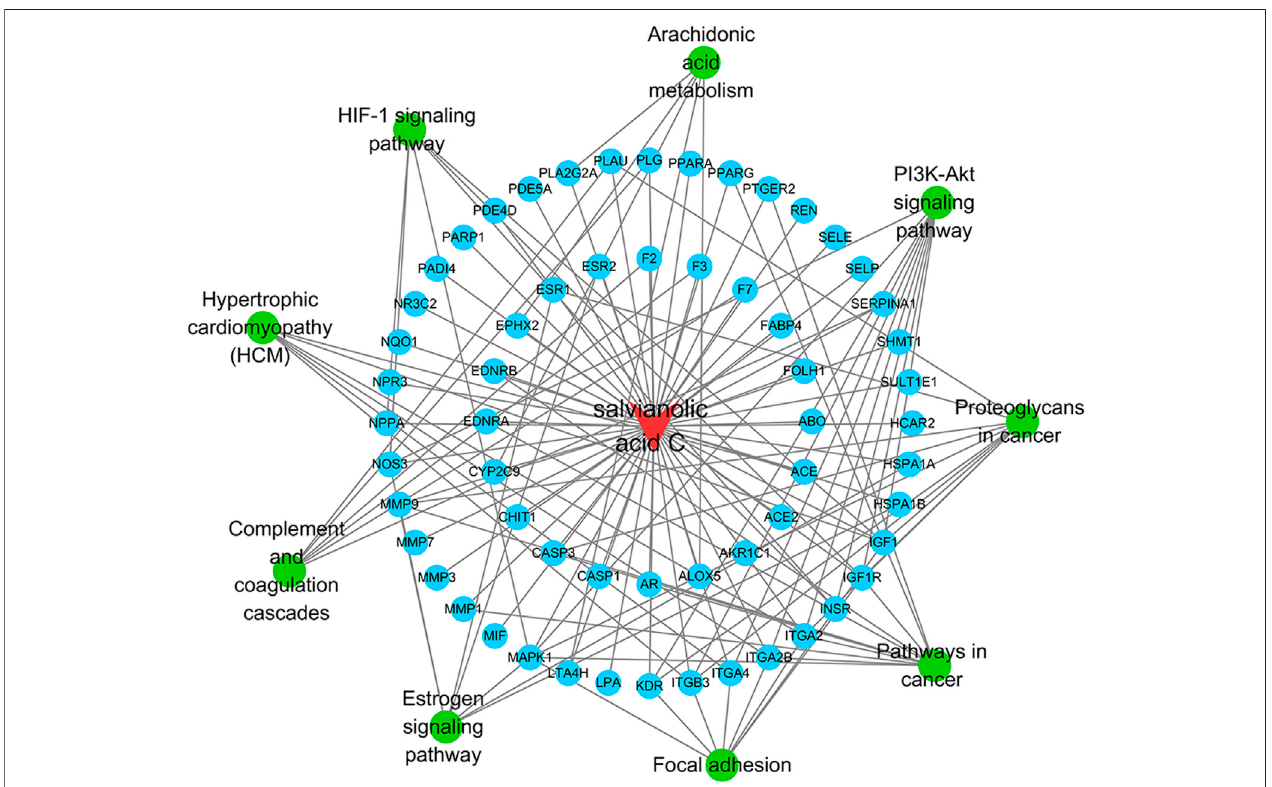
FIGURE 5 | SAC-target-pathway network. The red V shape, green circles, and blue circles represent SAC, targets, and KEGG pathway, respectively.